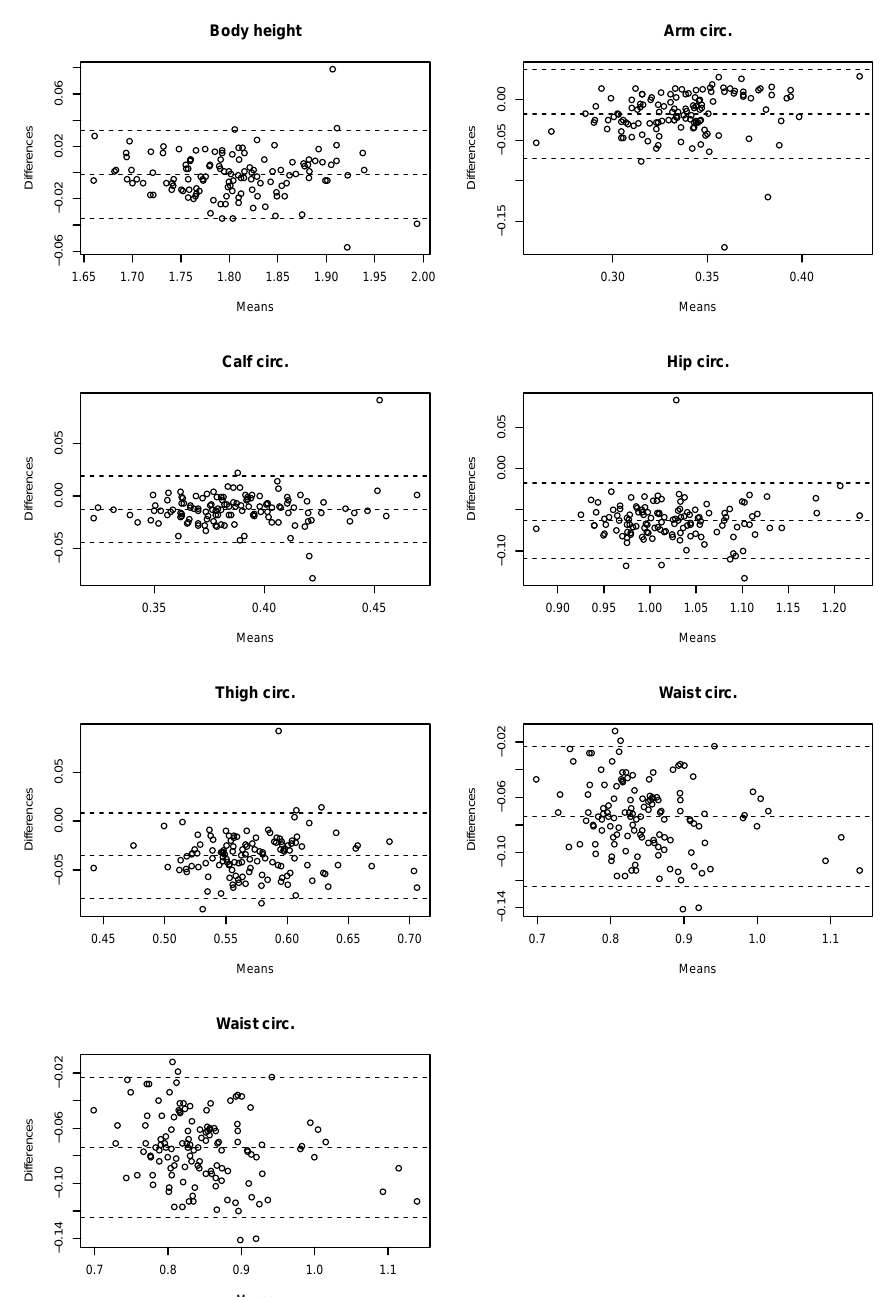
Figure 5. Bland–Altman plots for anthropometric parameters. The Kinect sensor is very often used as a tool to scan either the entire figure or selected body segments [22,28,29,40,41,43]. However, the direct comparison of errors is complicated by the use of different quality criteria. For example, in the work [22], the TEM criterion (the relative technical error of measurement) was defined, whose value was calculated at 0.88%. In the work of [28], where a 3D foot scanner based on a Kinect camera was presented, the RMSE (Root mean squared error) criterion was used. The RMSE error was calculated against a high-resolution laser scanner and was 2.8 mm. In another paper [40], where Kinect v2 was also used to estimate selected anthropometric parameters, the authors inferred that the differences between the estimated values and the traditional measure- ments show statistical significance, which confirms the results we obtained, presented in Table 1. Naufal et al. [41] studied a total of 147 subjects. The results measured